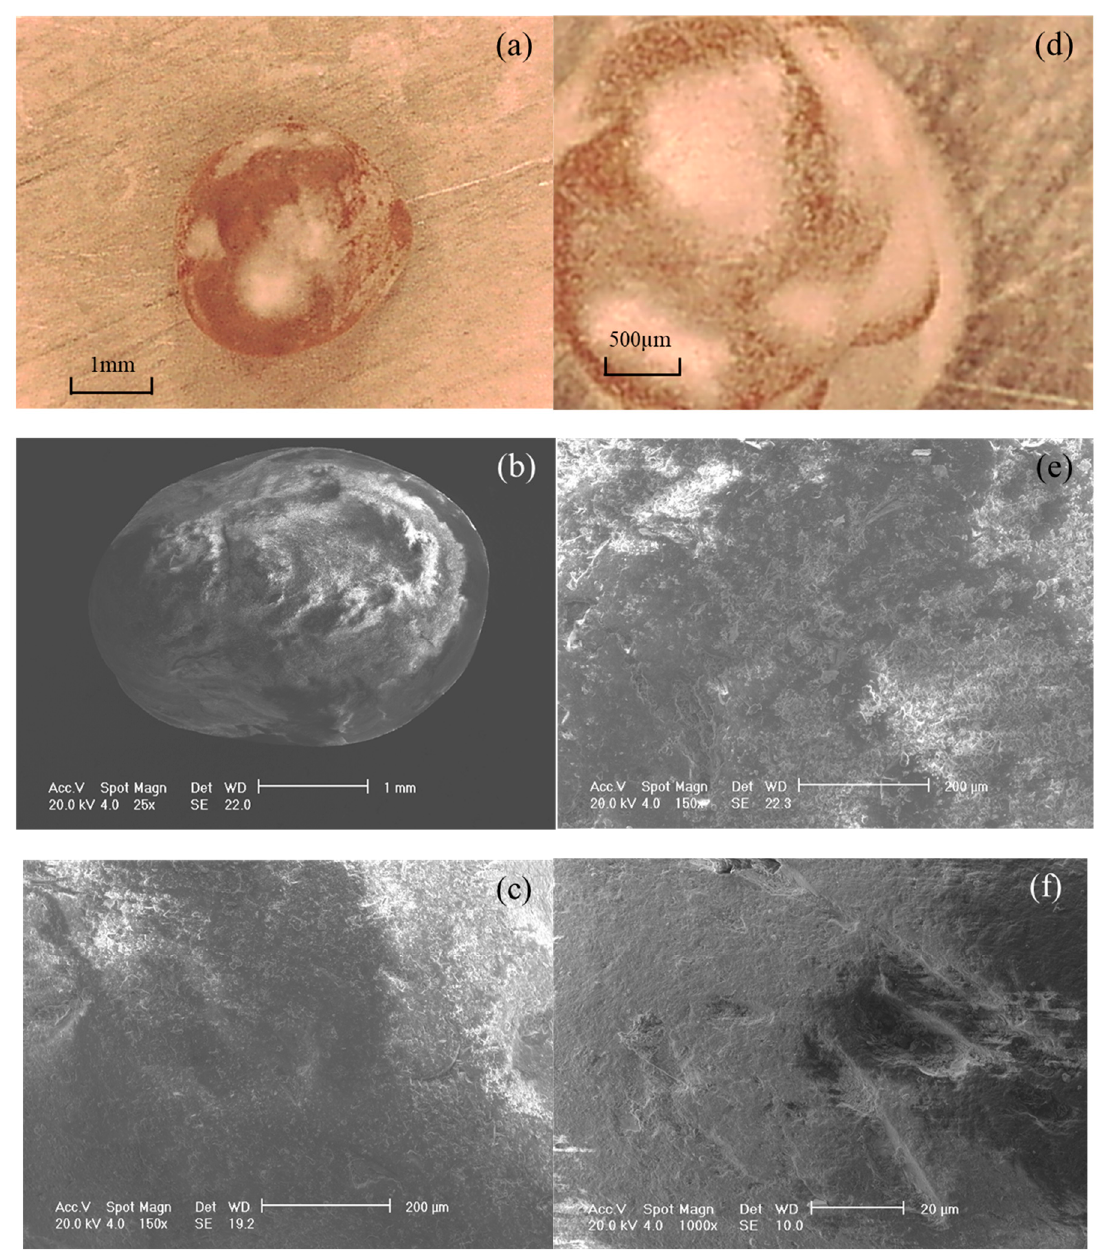
Figure 2. Typical images of coated LBS grains at different scales: ( a ) microscopic image for 150 mg/mL; ( b ) SEM image for 150 mg/mL; ( c ) SEM image for 150 mg/mL; ( d ) microscopic image for 300 mg/mL; ( e ) SEM image for 100 mg/mL; ( f ) SEM image for uncoated LBS.